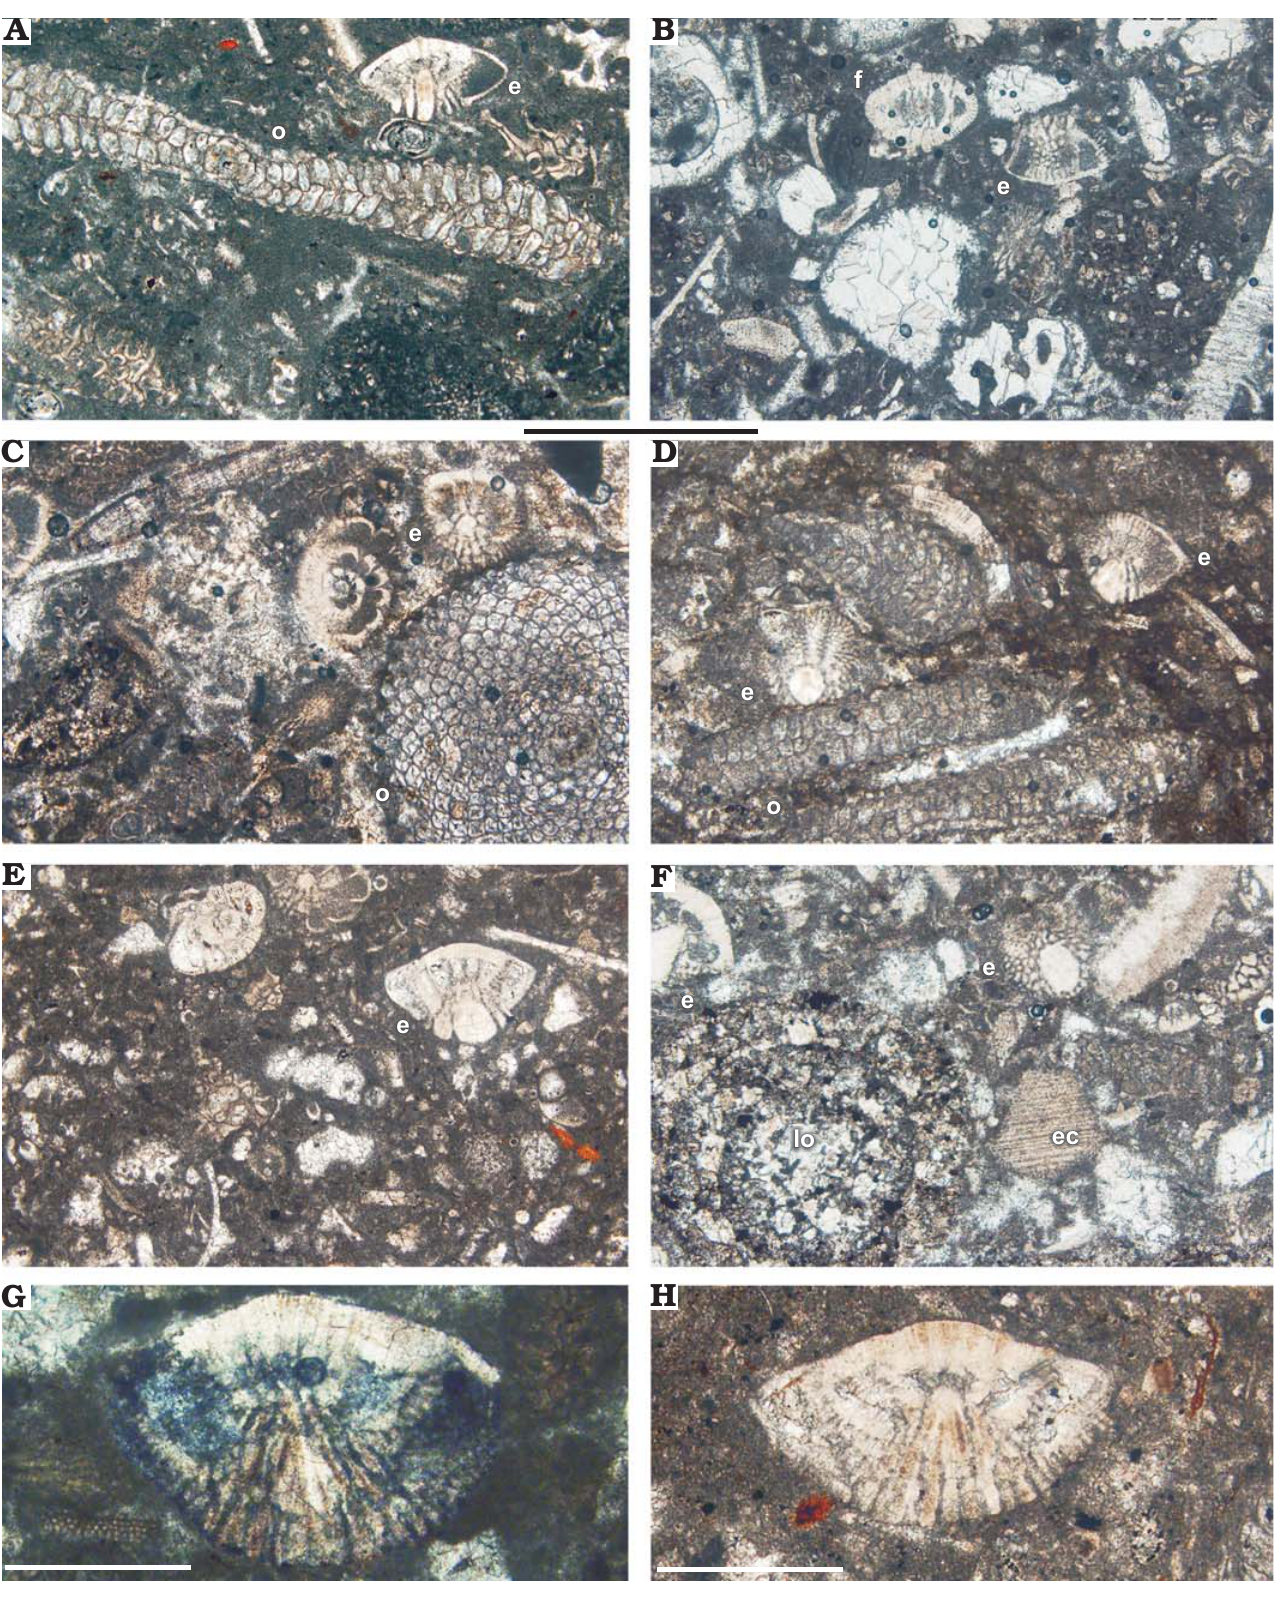
Fig. 6. A – F . Facies from the Tarbur Formation of Rod Abad section, Iran. A , C , D . Packstone with Pseudomphalocyclus blumenthali Meriç, 1980 (o) and Elazigina siderea sp. nov. (e). B , E . Packstone-wackestone with Fissoelphidium operculiferum Smout, 1955 (f), Elazigina siderea sp. nov. (e), and mollusc fragments. F . Packstone-grainstone with Loftusia (lo) and echinoderm fragments (ec). G , H . Orbitokathina sp. G . APNU-Tf14. H . APNU-Tf12. Scale bars A–F, 1 mm; G, H, 0.5